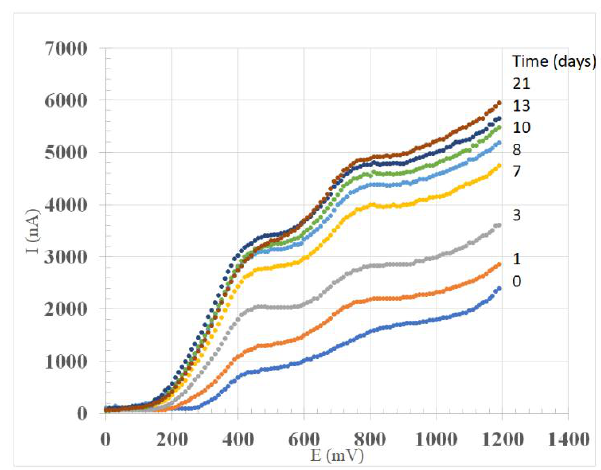
Figure 1. Linear sweep voltammetry during maceration of red wine Sangiovese up to 21 days.